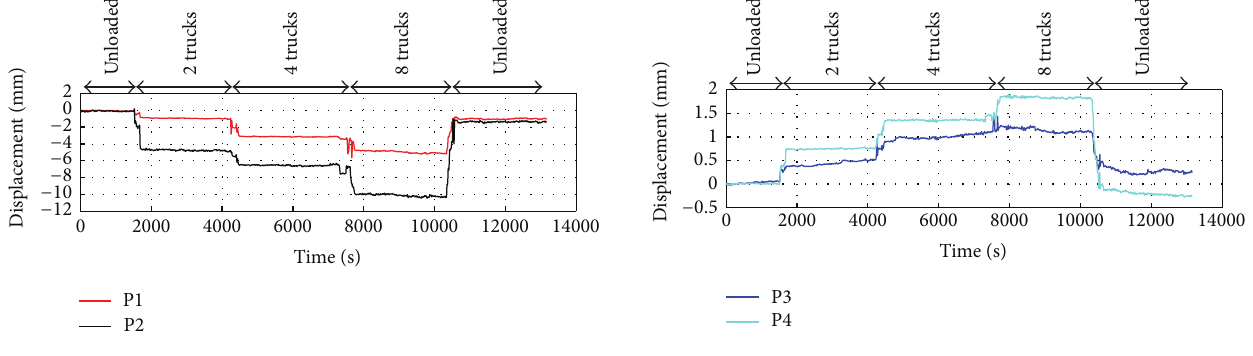
Figure 8: Measured displacements of P1 and P2 during the load test.